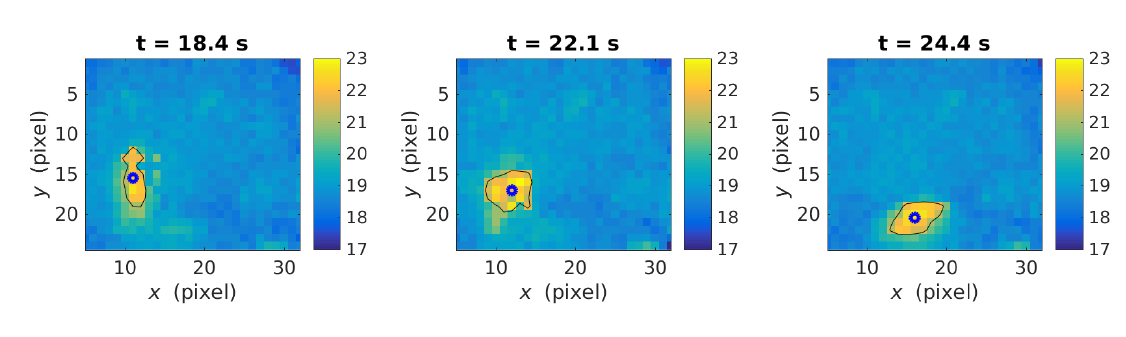
Figure 5. Three different moments during a fall. The blue circle is the